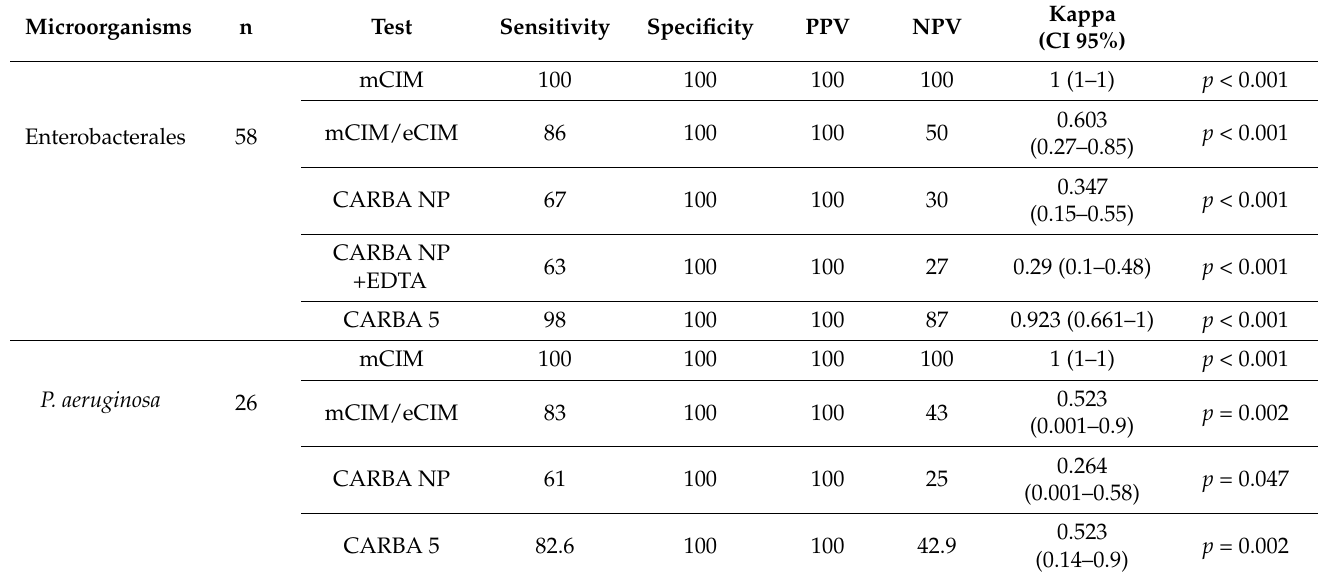
Table 1. Accuracy of the phenotypic test and NG-Test CARBA 5 ® compared to